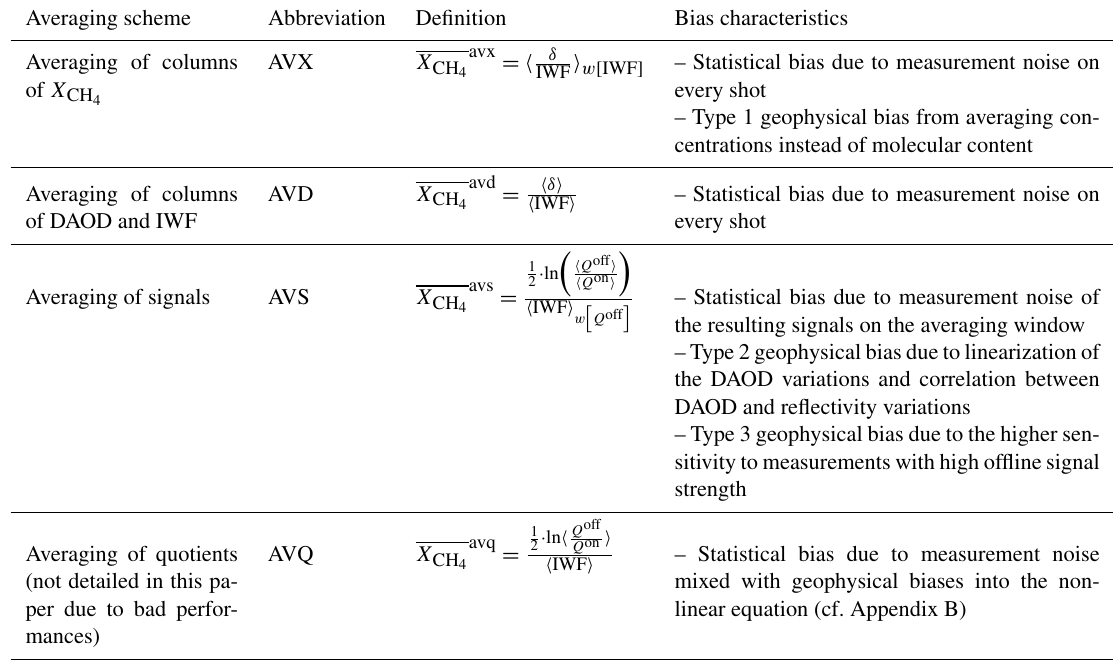
Table 1. Averaging schemes and characteristics of their biases.